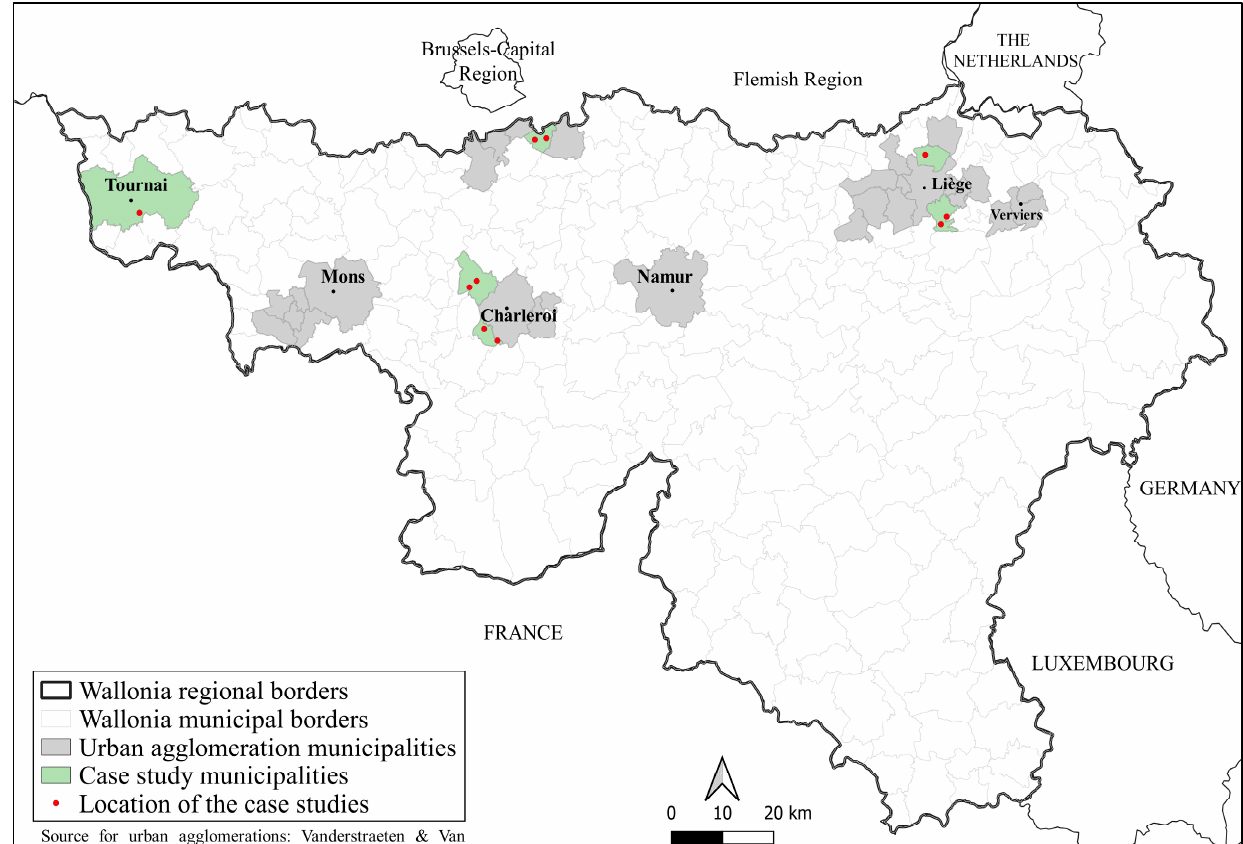
Figure 1. Location of the Walloon urban agglomerations and the case studies [28].